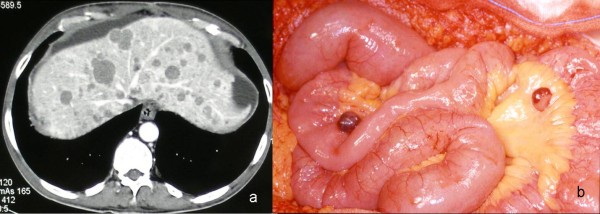
Metastases from primary GIST tumors. a) CT scan of liver mestastases from GIST tumor. b) Peritoneal metastases from primary GIST tumor.